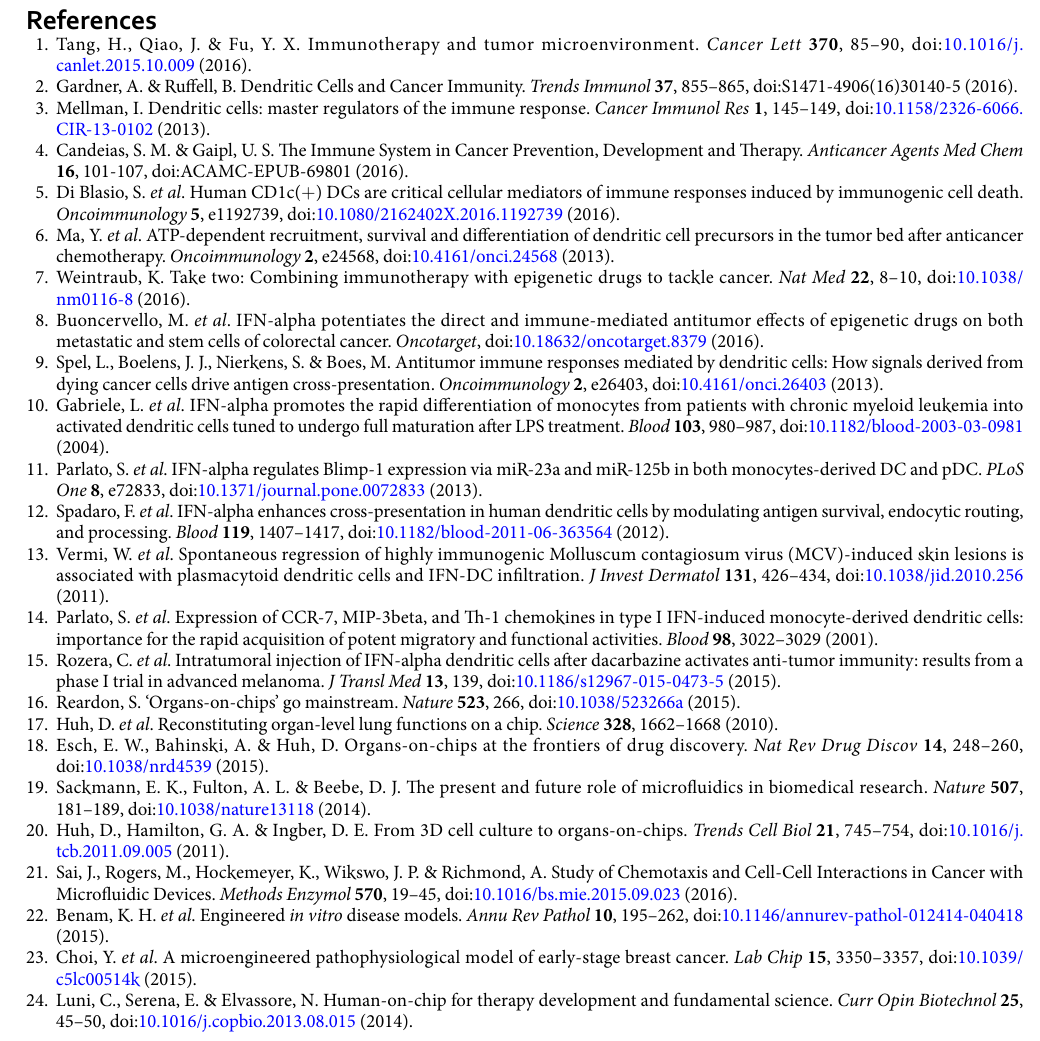
Table 3. Each well contained specific primers and a Universal ProbeLibrary Probe. The mean of expression of three different housekeeping genes (HPRT1, GAPDH andPGK1) was used to normalize the data. The qPCR assays were run in a Roche LightCycler ® 480 following the manufacturer’s instructions. qPCR assays were run in at least 3 independent assays. Statistical analyses. Each experiment was repeated at least three times, yielding comparable results. Graphpad Prism v.5.03 (La Jolla, CA) and Microsoft Excel were used to graph the data as mean ± s.d. or s.e.m. and to calculate P -values using the two-tailed unpaired Student’s t-test. In all experiments, a P -value ≤ 0.05 was considered as statistically